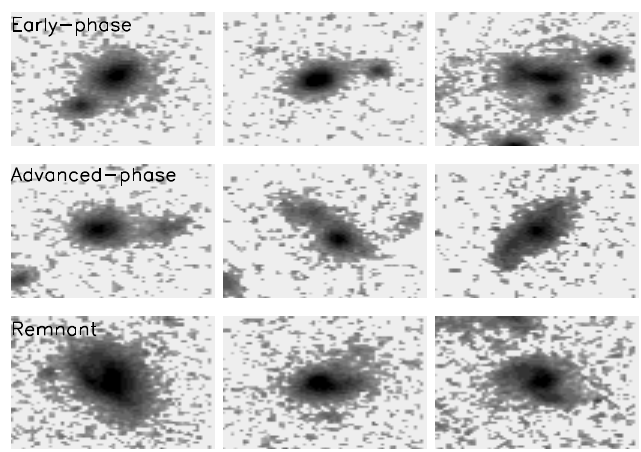
Fig. 7. Examples of different merging types: early-phase mergers, advanced-phase mergers, and merger remnants. The size of each image is 4 ′′ (cid:2) 4 ′′